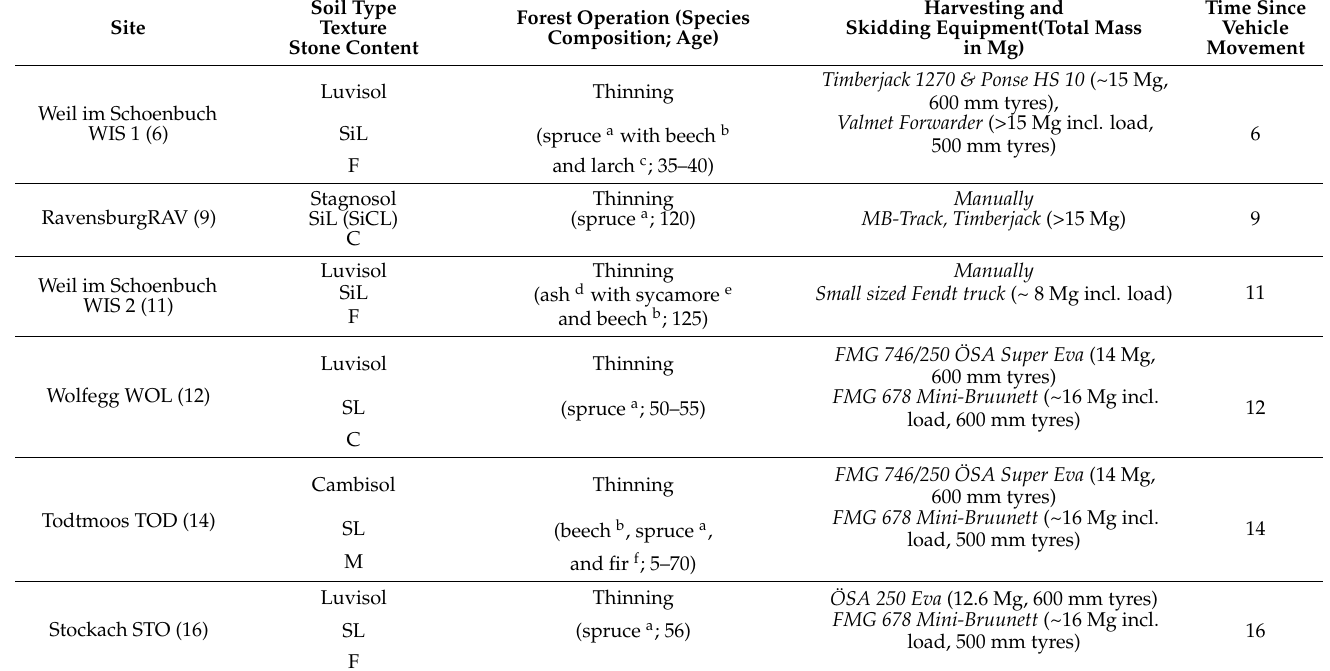
Figure 1. Location of the 11 investigation sites in Baden-Wuerttemberg (Germany). Table 1. Site conditions, logging operations, and time span of soil structure recovery.